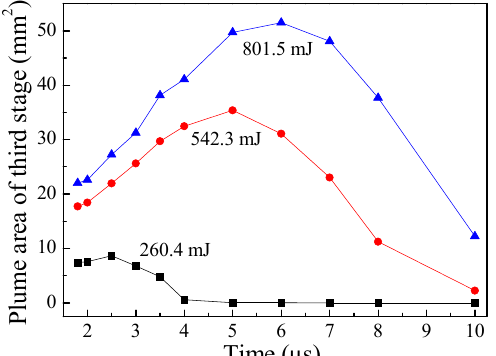
Figure 16. The total plume area variation with time and the linear fitting of initial plume total area at different energies (ambient pressure 0.005 Pa and 26.5% Al).